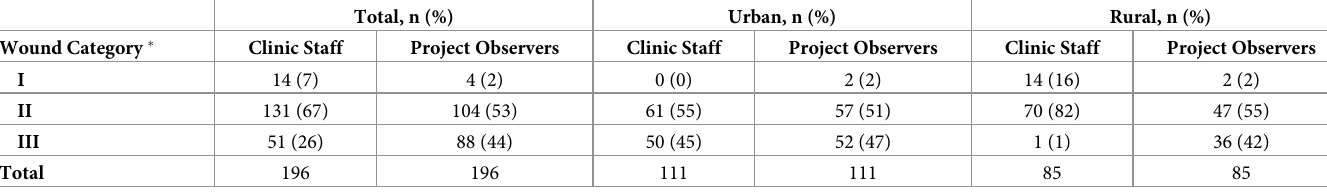
Table 3. Wound categories assigned by clinic staff and project observers for 196 patients seeking care for animal wounds and possible rabies virus exposures at five selected rabies clinics in county A, Hunan Province, China,